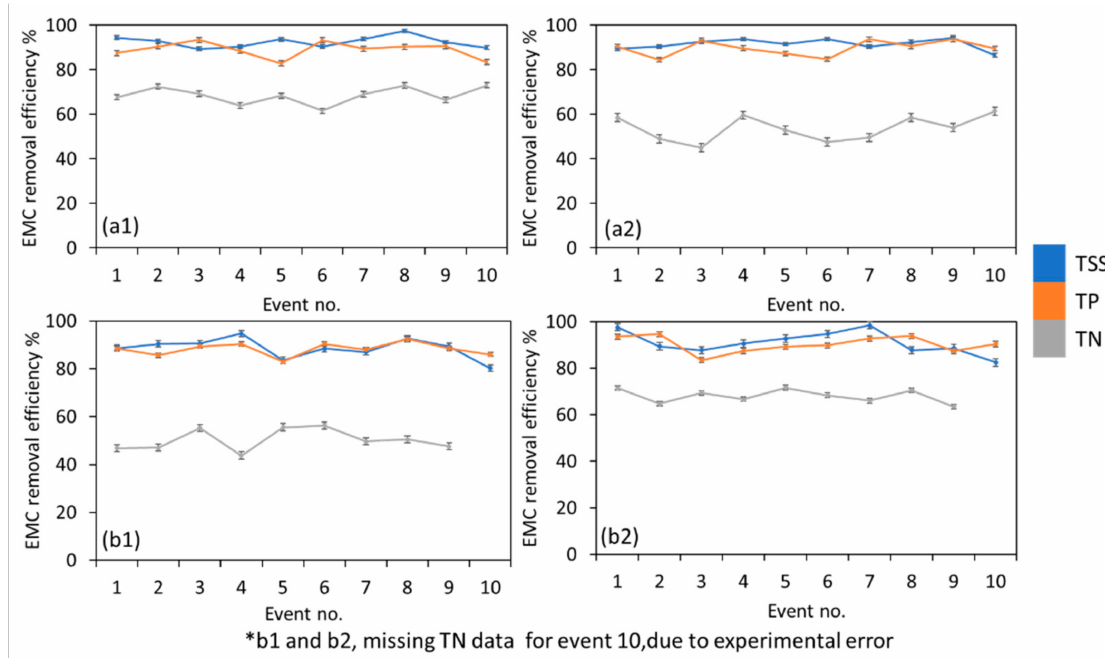
Figure 4. Phase 1 EMC removal efficiency of TSS, TP and TN for ( a1 ) TT1 in dry condition, ( a2 ) TT2 in dry condition, ( b1 ) TT1 in wet condition, ( b2 ) TT2 in wet condition.